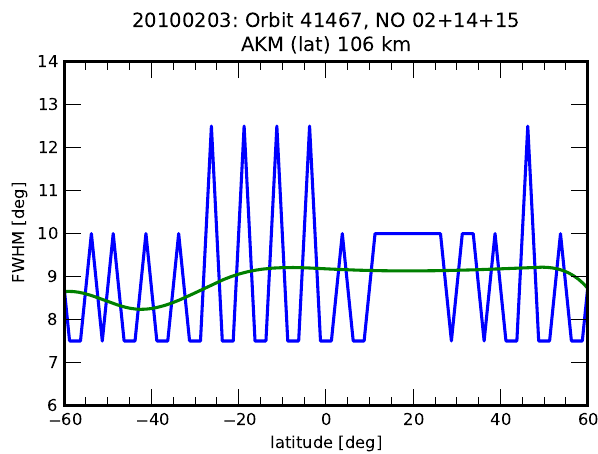
Fig. 9. FWHM of the latitude averaging kernel matrix elements for a sample orbit (no. 41467, 3 February 2010). The apparent large variation is due to the grid spacing of 2.5 ◦ . The green line is a smoothed cubic B-spline fit indicating an average latitudinal res- olution of about 9 ◦